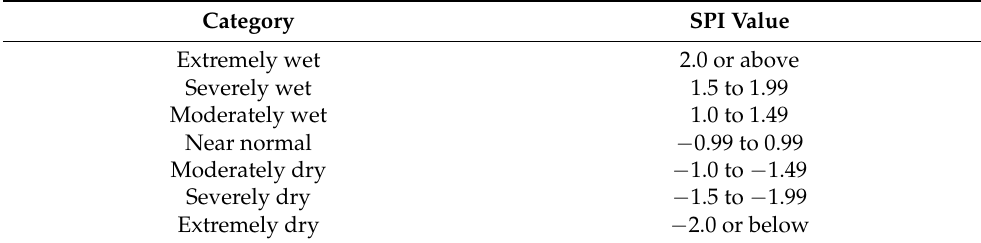
Table 1. Drought categories according to SPI